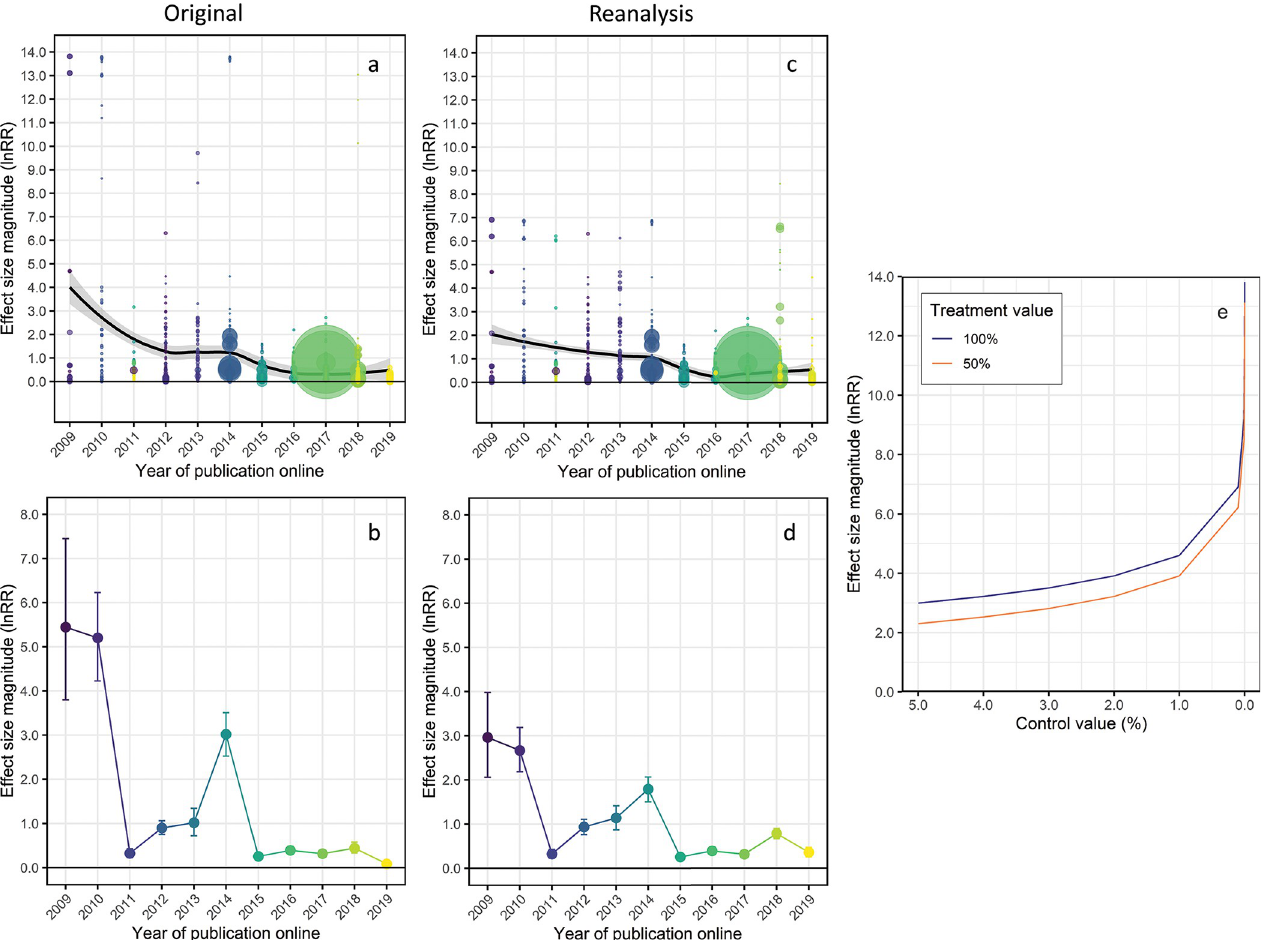
Fig 1. Reanalysis of effect sizes in studies on the impacts of ocean acidification on fish behaviour. (a, b) Original analysis by Clements and colleagues using 0.0001 to replace zero values in percentage and proportional data and (c, d) reanalysis with the corrected, updated, and screened data set using 0.1 to replace zero values in percentage data and 0.001 to replace zero values in proportional data. Top row (a, c) shows all calculated effect sizes (lnRR) fitted with a Loess curve and 95% confidence bounds. Bottom row (b, d) shows the modelled variance–weighted average effect sizes by year. Experiments with smaller variance are given greater weight in calculating the model means in the bottom row. Panel (e) shows how effect sizes are exaggerated when values below 1 are used to replace zeros in percentage data. The calculated effect size magnitude (lnRR = ln(treatment mean/control mean)) is shown for treatment means of 100% and 50% and control mean values between 5% and 0%, illustrating the inflation of lnRR caused by values below 1% in the denominator. The data underlying this figure (a–d) may be found in https://doi.org/10.25903/jw8m–9007. The data underlying panel (e) are found in S1